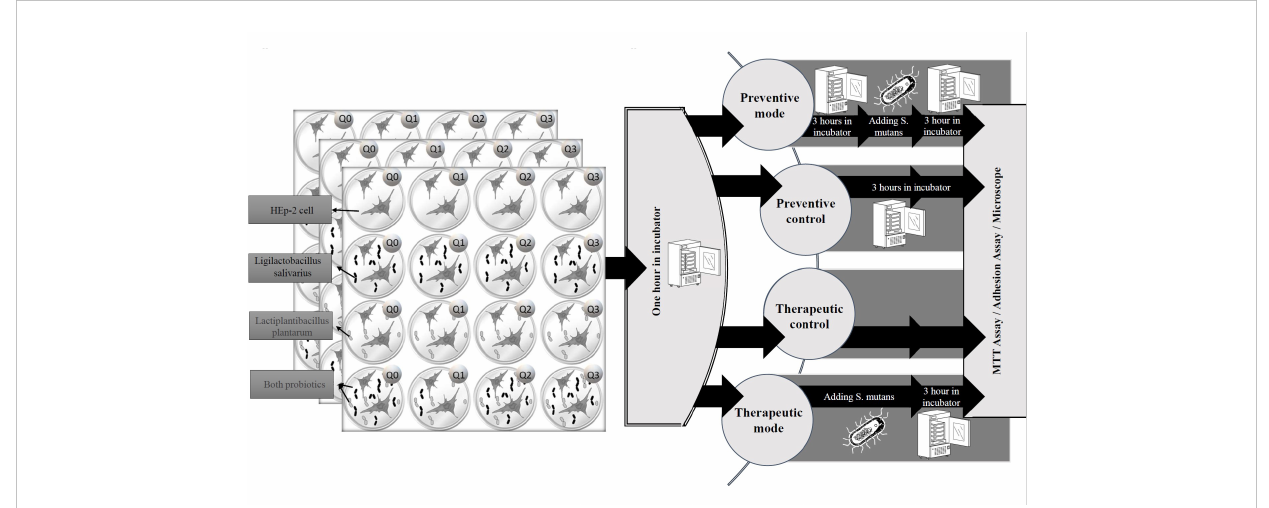
FIGURE 1 The experimental protocol. The study was conducted on treatment and preventive settings. In treatment mode, HEp-2 cells were infected by S. mutans immediately after administration of probiotics or Q10, and in preventive mode, the probiotics or Q10 were added three hours before